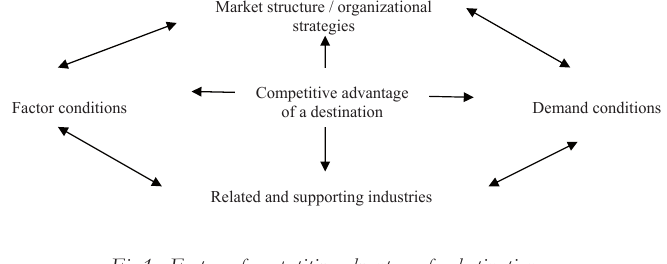
Fig 1 - Factors of competitive advantage of a destination Source: Ritchie & Crouch,